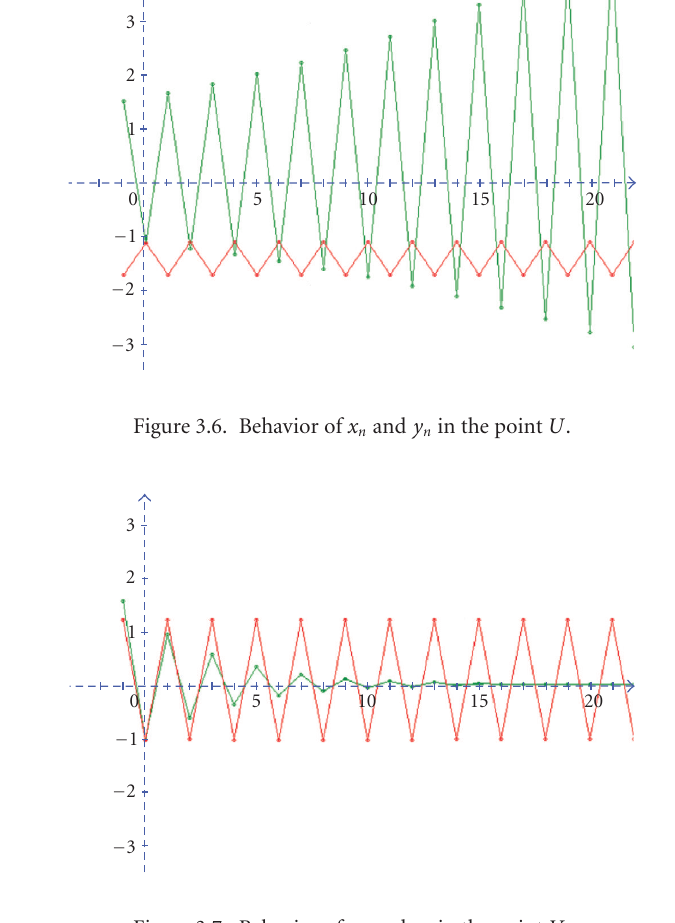
Figure 3.7. Behavior of x n and y n in the point V